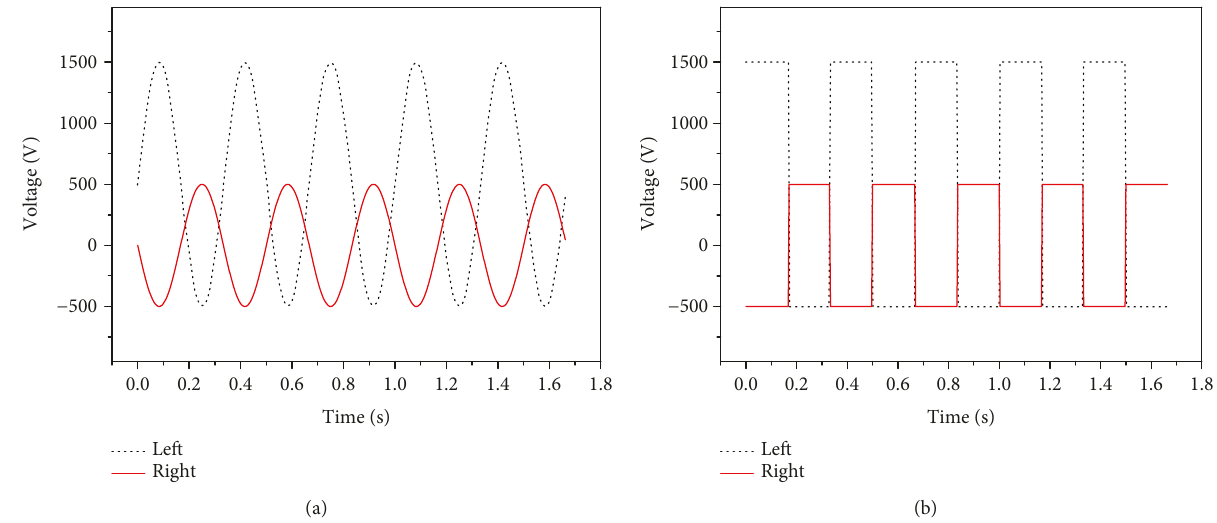
Figure 13: Waveforms on both MFC actuators at 3Hz in the motion of turning right. (a) Input voltages in sine waveform. (b) Input voltages in square